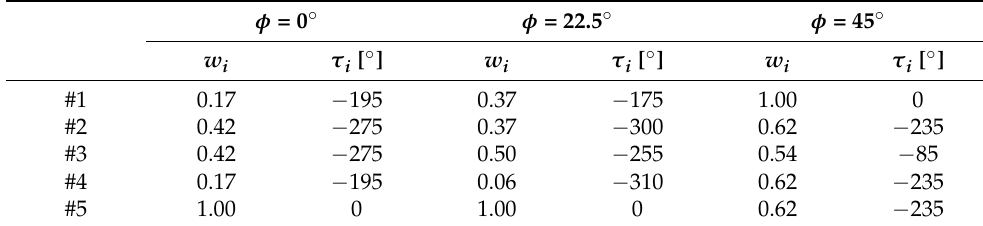
Table 1. Optimal weight